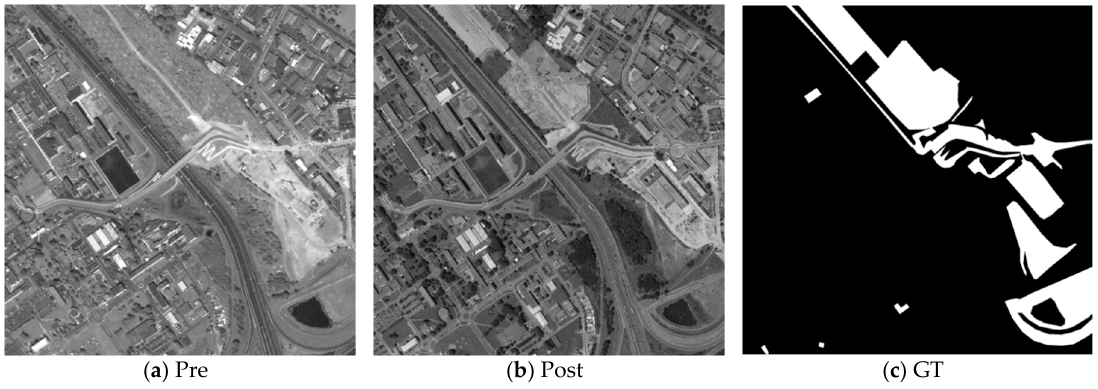
Figure 18. Image pair-5: Pleiades / Worldview2.